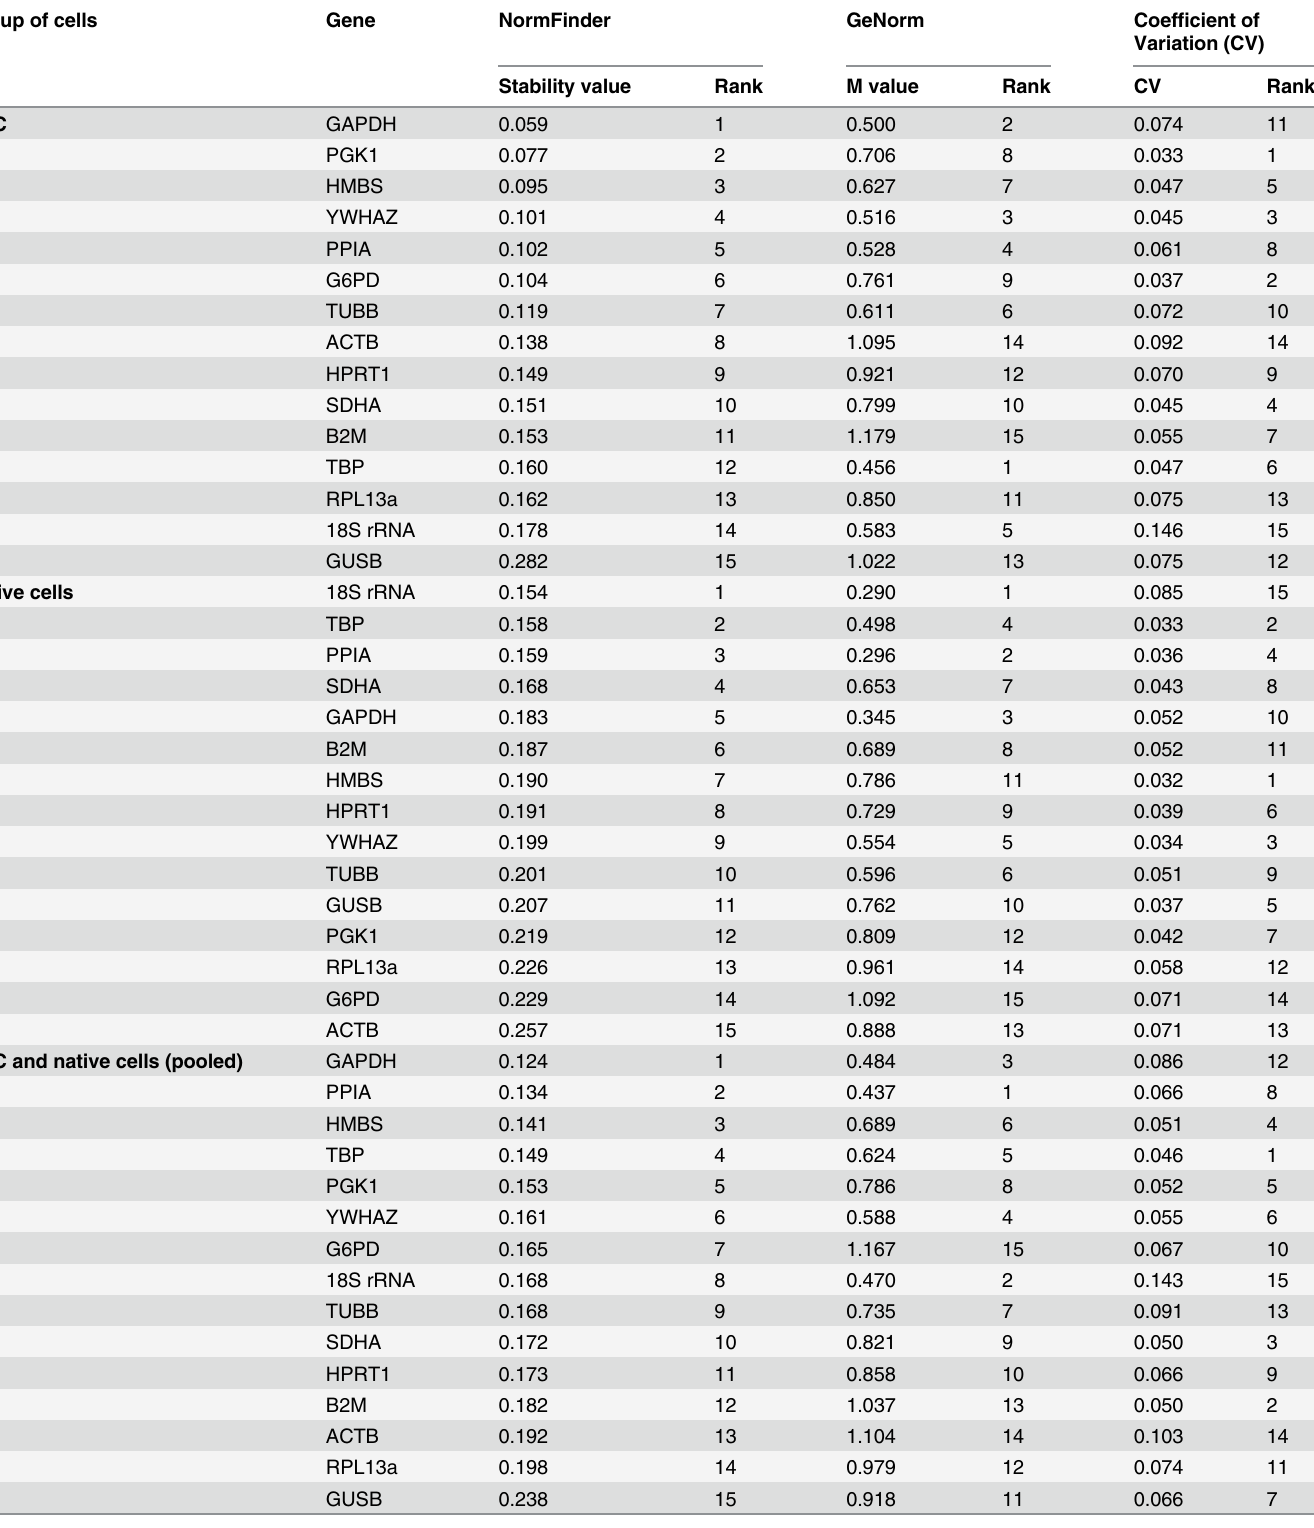
Table 4. Ranking of the stability of the expression of candidate reference genes by NormFinder, geNorm, and CV analyses. Group of cells